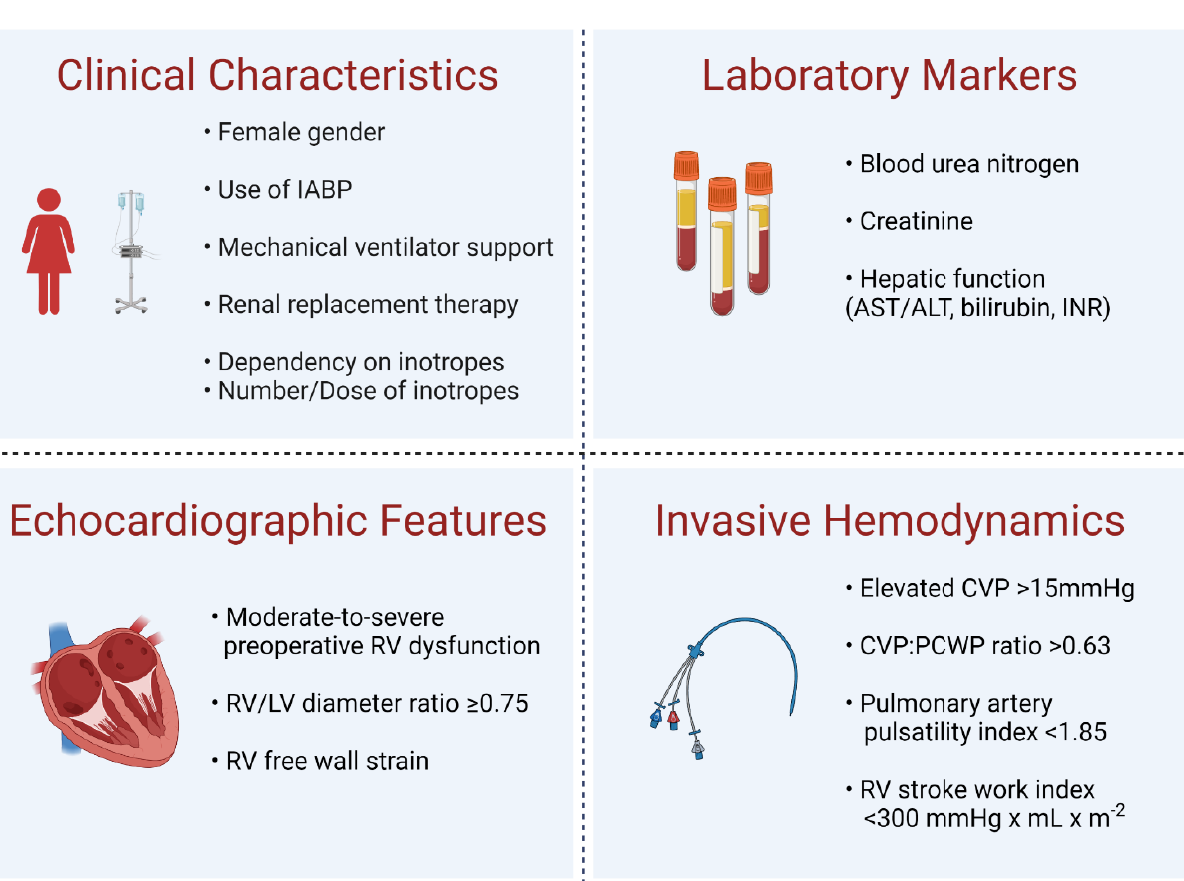
Figure 2. Risk factors associated with post-LVAD right heart failure: CVP = central venous pressure; IABP = intra-aortic balloon pump; LV = left ventricle; PCWP = pulmonary capillary wedge pressure; RV = right ventricle. Created with BioRender.com, accessed on 22 April 2022.